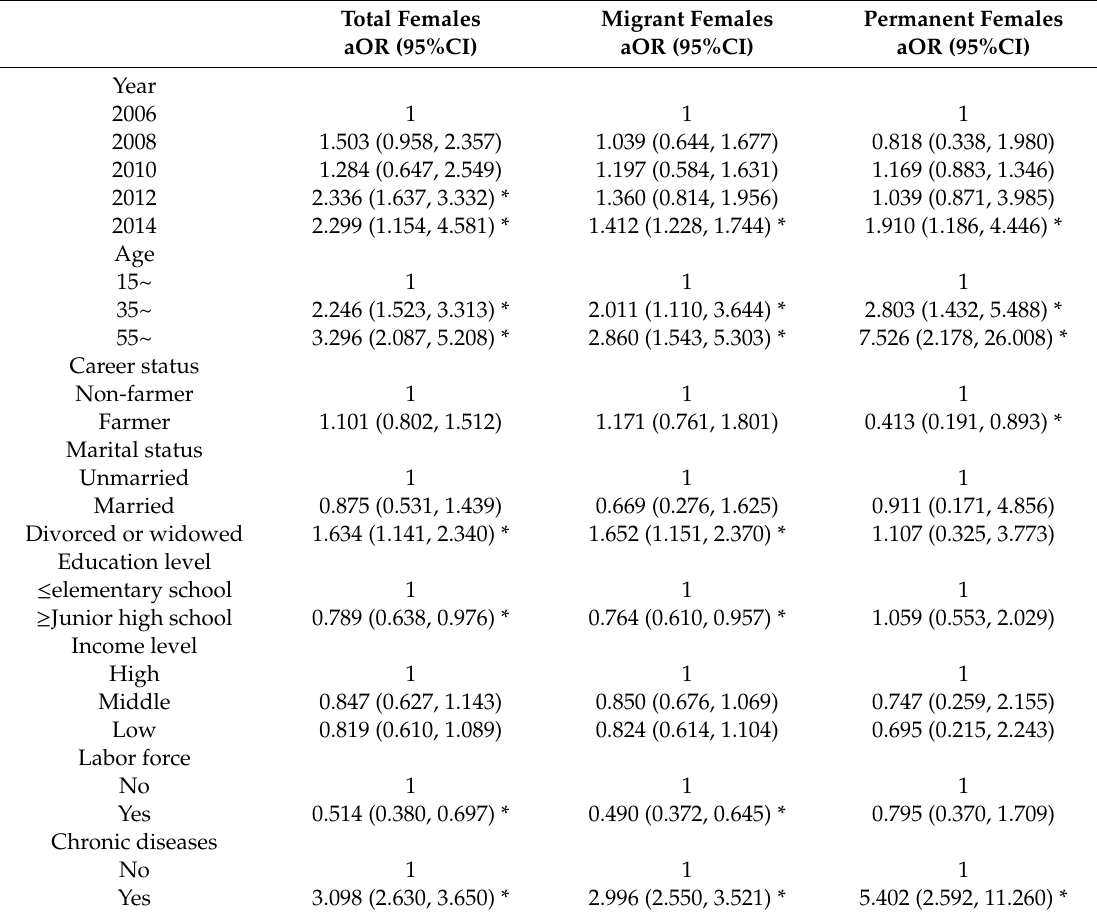
Table 4. The analysis results of hospitalization due to illnesses using complex sampling logistic regression of females aged 15 and over among total, migrant, and permanent females. aOR: adjusted Odds